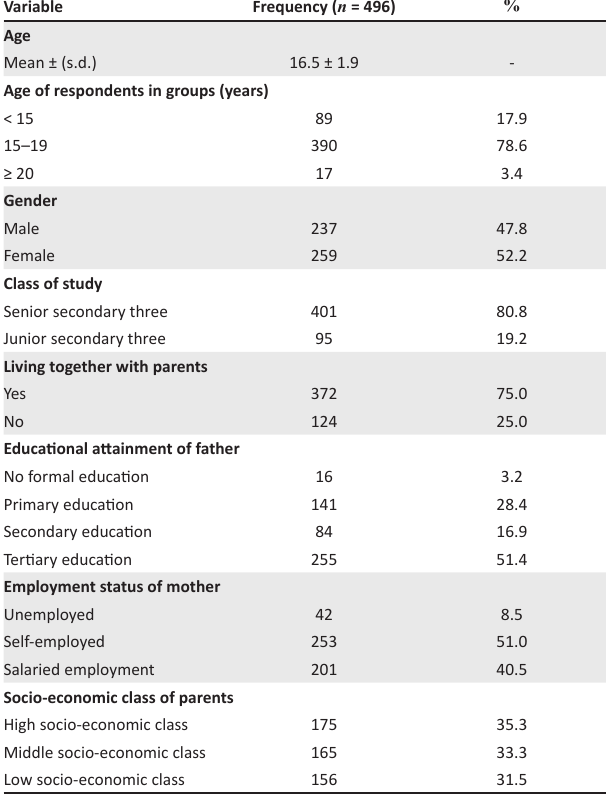
TABLE 1: Socio-demographic characteristics of